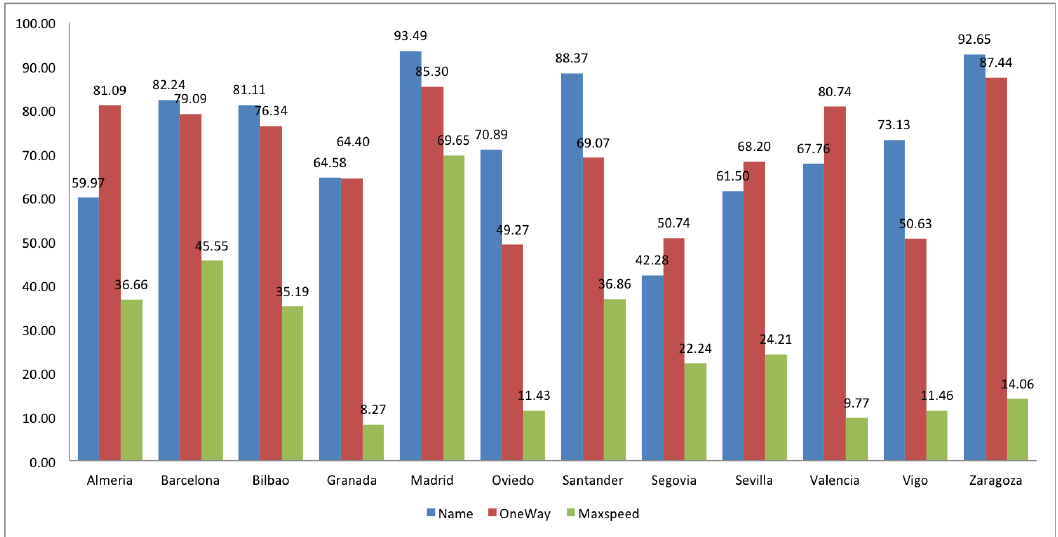
Figure 3. Completeness study in Spain. Percentage of attributes name, oneway and maxspeed in